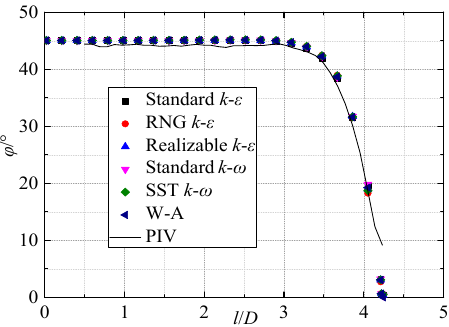
Figure 4. Flow angle φ along the jet centerline.